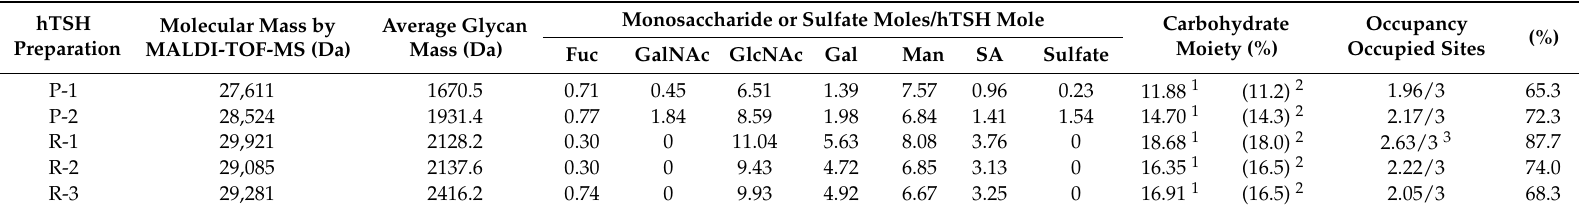
Table 2. Average N -glycan mass, monosaccharide or sulfate/hTSH molar ratio, carbohydrate moiety and occupancy determination based on N -glycoprofiling and MALDI-TOF-MS analysis of the different hTSH preparations.